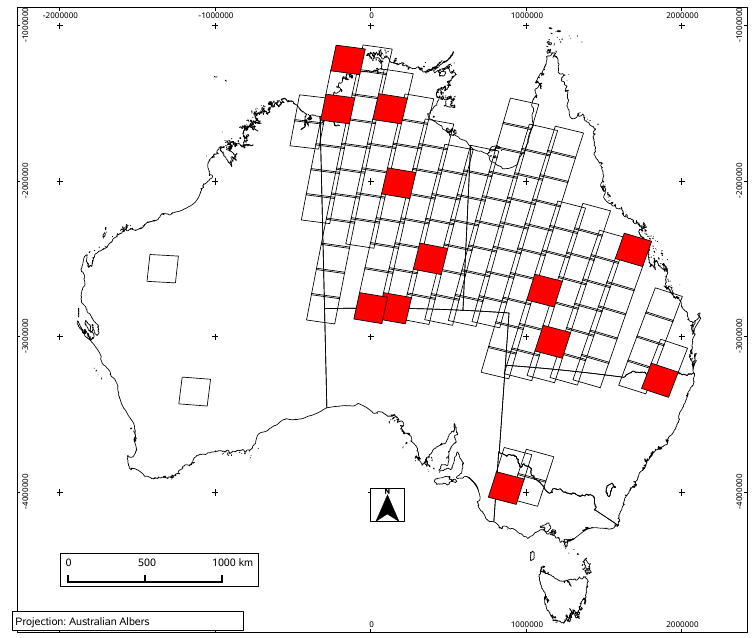
Figure 2. Locations of the scenes used in training and validation of comparisons between Landsat-7 ETM+ and Landsat-8 OLI. Scenes outlined in black were used for fitting only, scenes filled in red were used only for validation comparisons. The eastern-most WRS-2 path is path 090, the most westerly path is